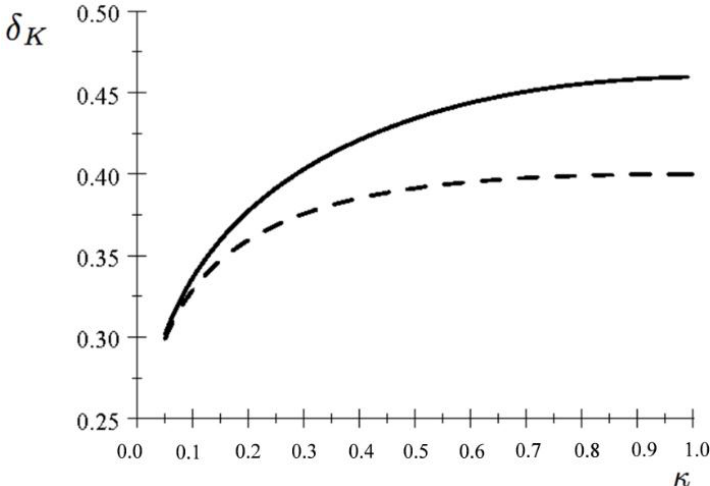
Figure 5. The critical discount factor for cooperation between moralists (solid curve) and altruists (dashed curve) in the repeated